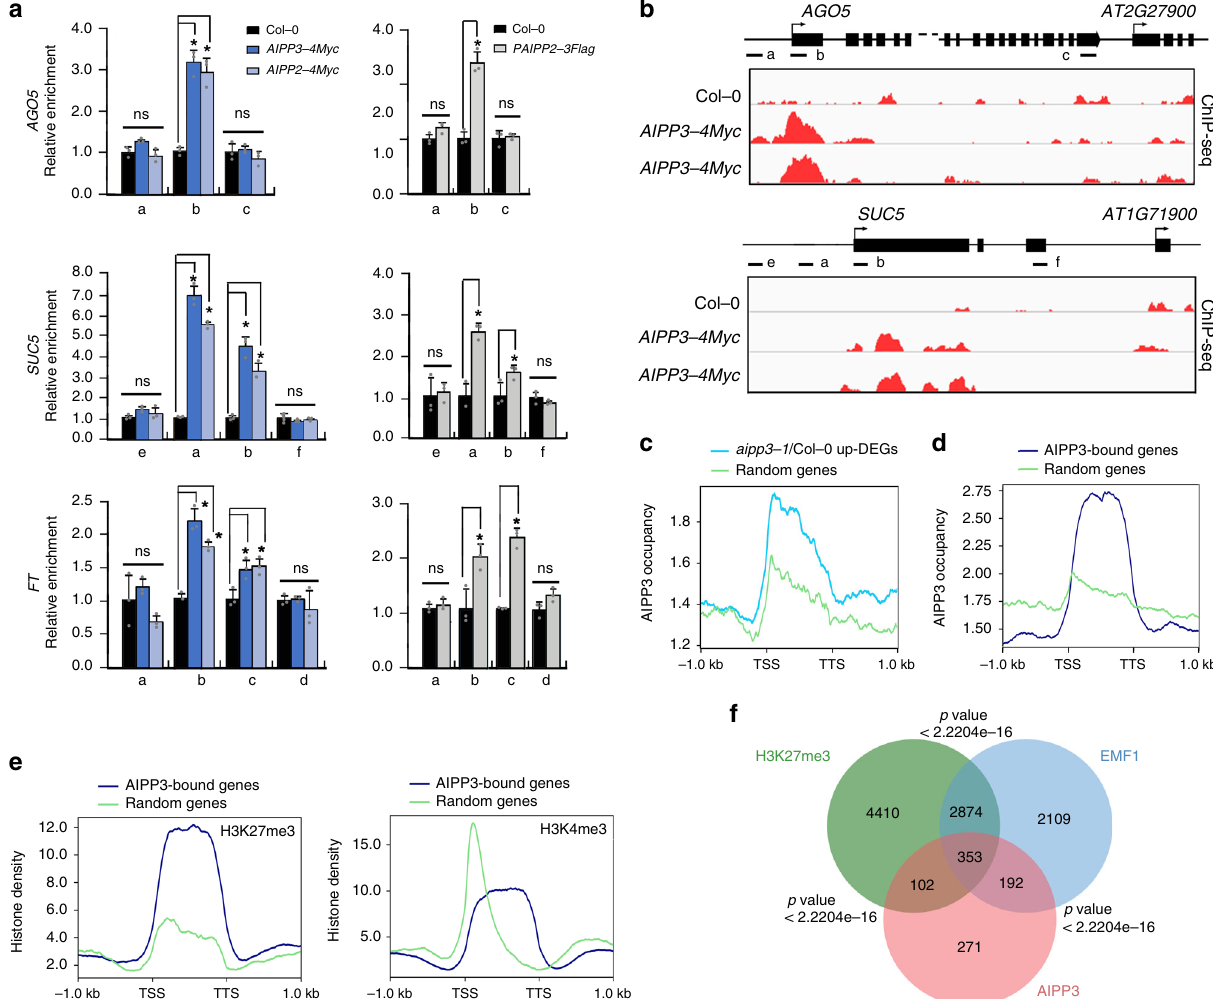
Fig. 5 BAH – PHD – CPL2 complex binds to the H3K27me3-marked genes to repress the transcriptional initiation and elongation of Pol II. a ChIP-qPCR showing the fold enrichments of AIPP3, AIPP2, and PAIPP2 on the selected genes. The occupancy was fi rst normalized to the internal control AtSN1 , and shown are relative fold enrichments compared to Col-0. The data are means± S.D. of three biological repeats. Unpaired one-tailed t test was performed and * p value < 0.01. b Snapshots of AIPP3-4Myc ChIP-seq showing the distribution of the AIPP3 protein at the selected genes. Note: the ChIP-qPCR and ChIP-seq results of AIPP3-4Myc were from independent samples. c , d The diagrams showing AIPP3 occupancies on aipp3-1 up-DEGs ( b ) and AIPP3-bound genes ( c ). e The diagrams showing the H3K27me3 (left) and H3K4me3 (right) density on AIPP3-bound genes. Random regions serve as negative controls. f A Venn diagram showing the overlap between AIPP3-bound genes, H3K27me3-enriched genes, and